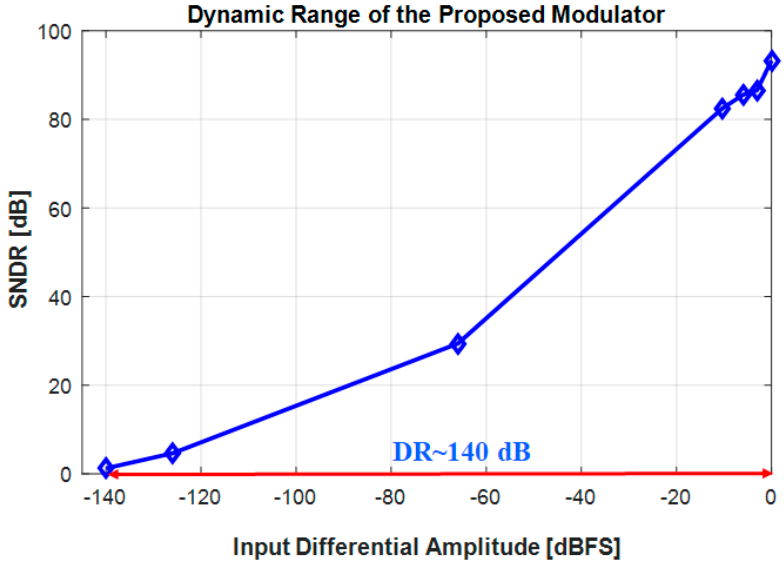
Figure 20. The proposed ΔΣ modulator’s dynamic range.